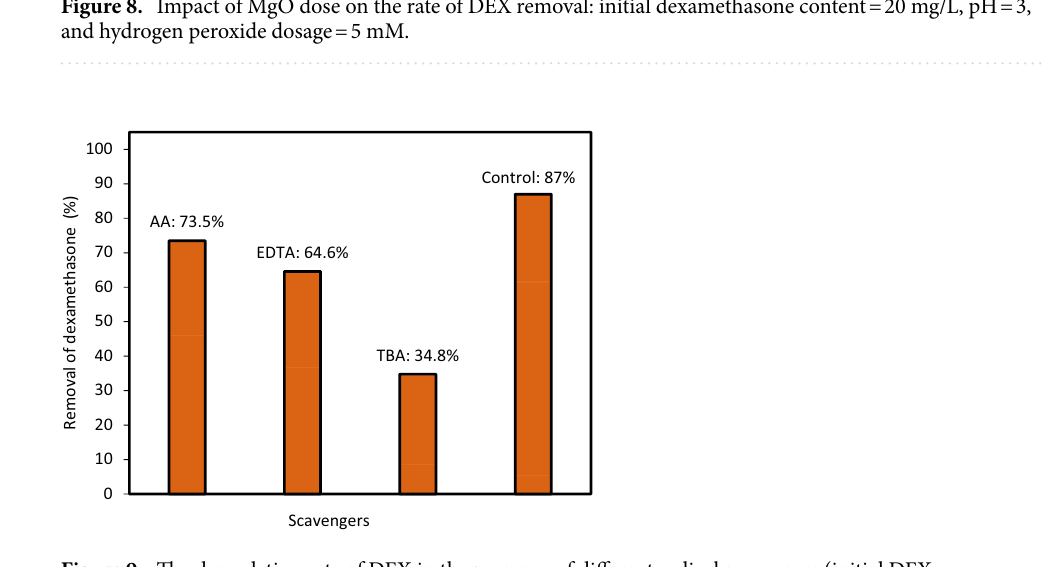
Figure 9. The degradation rate of DEX in the presence of different radical scavengers (initial DEX concentration = 20 mg/L, pH = 3, H 2 O 2 dose = 5 mM, and MgO dose = 0.05